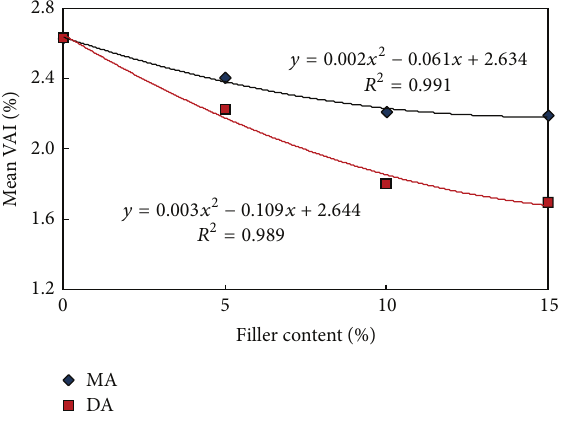
Figure 11: SAIs of asphalt mastics versus content after TFOT.